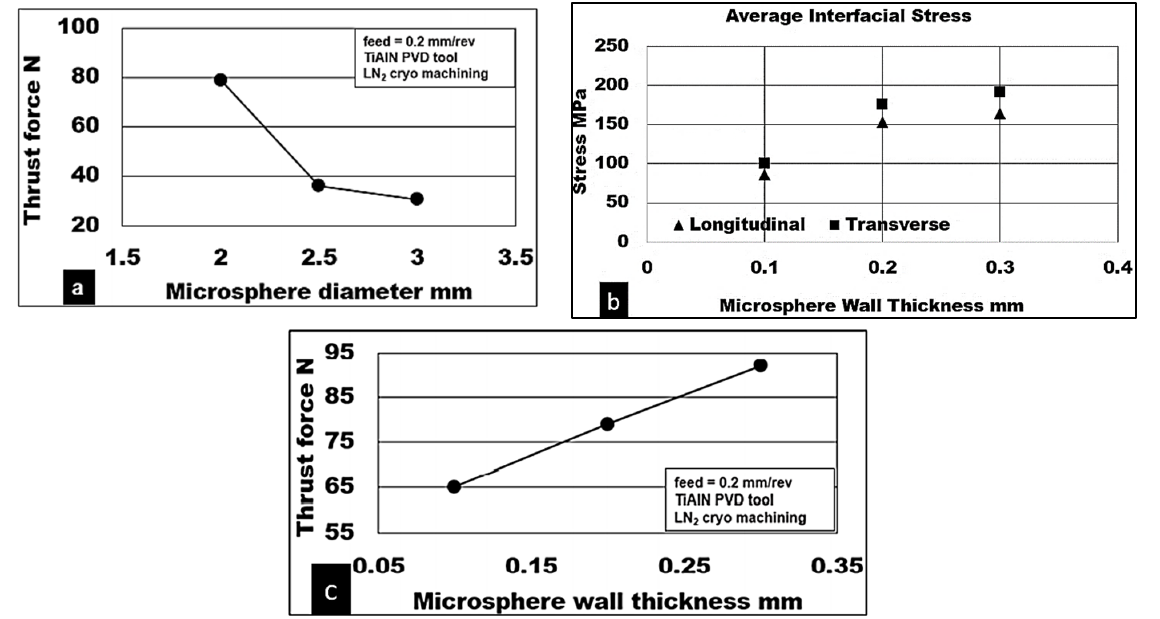
Figure 6. Microsphere damage model for drilling thrust force and von Mises stress.